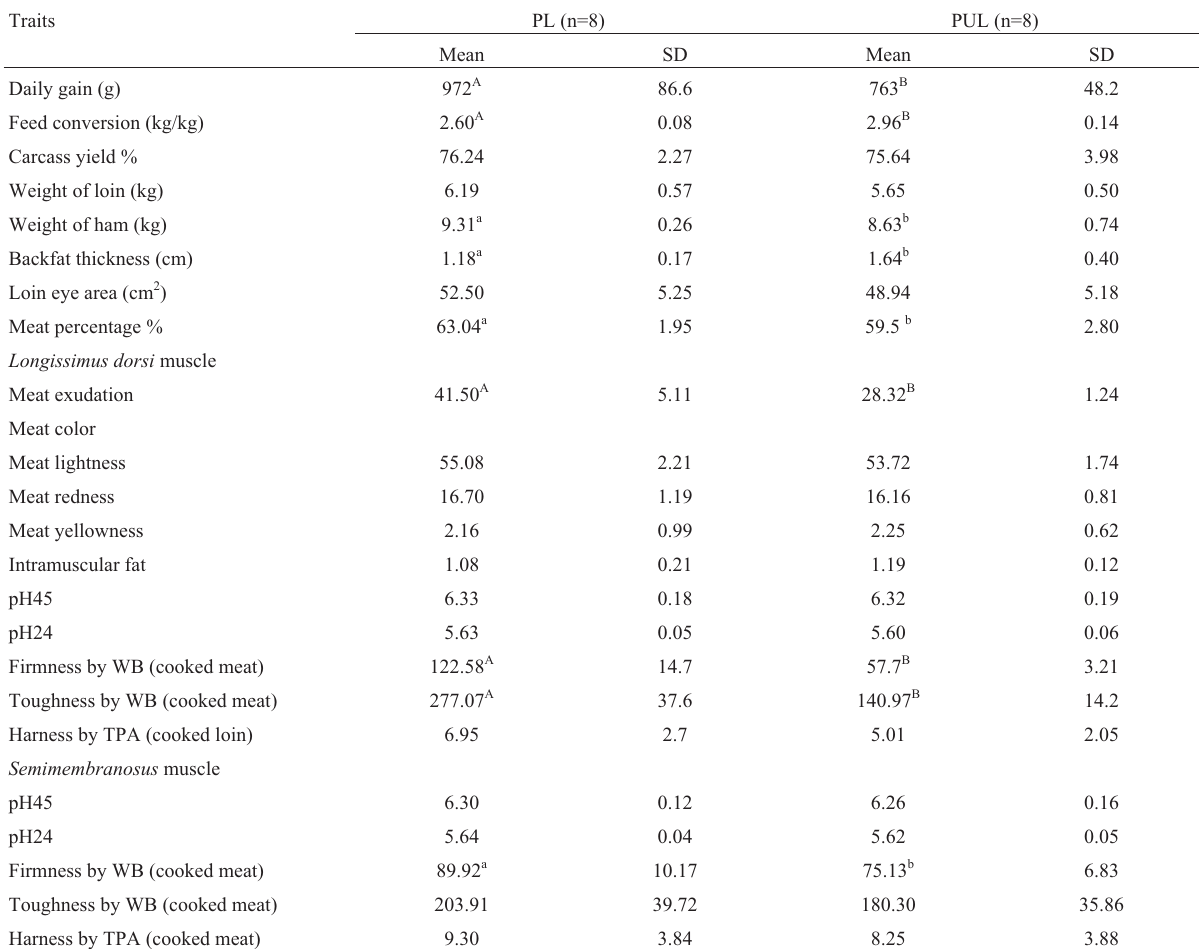
Table 1 - Characteristics of the pig, breeds, means (cid:2) SD. Traits